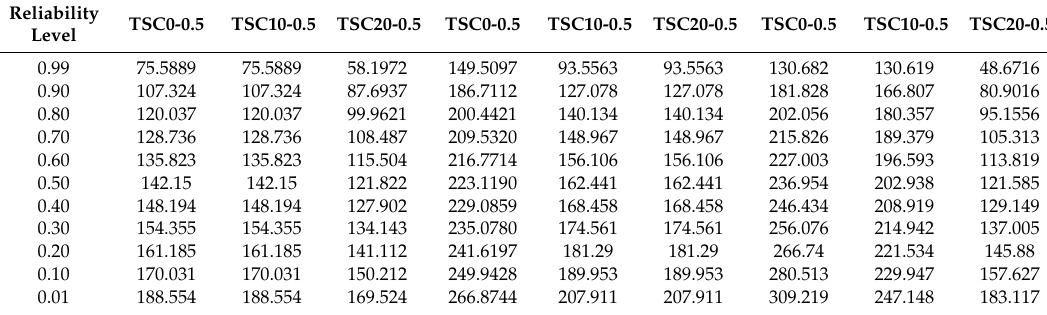
Table 5. Weibull distribution for impact energy (J) of various TSC specimens. Reliability